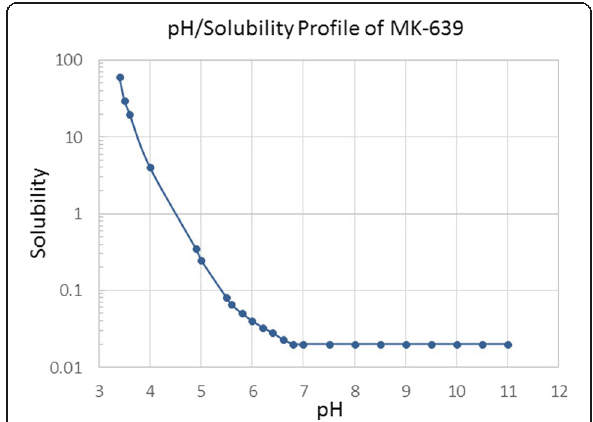
Fig. 3 pH solubility profile of indinavir (adapted from Ref (Lin et al. 1998))